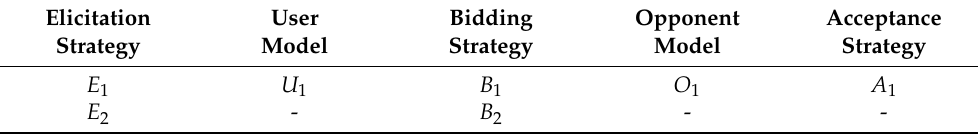
Table 1. Example of existing EUBOA model. Elicitation